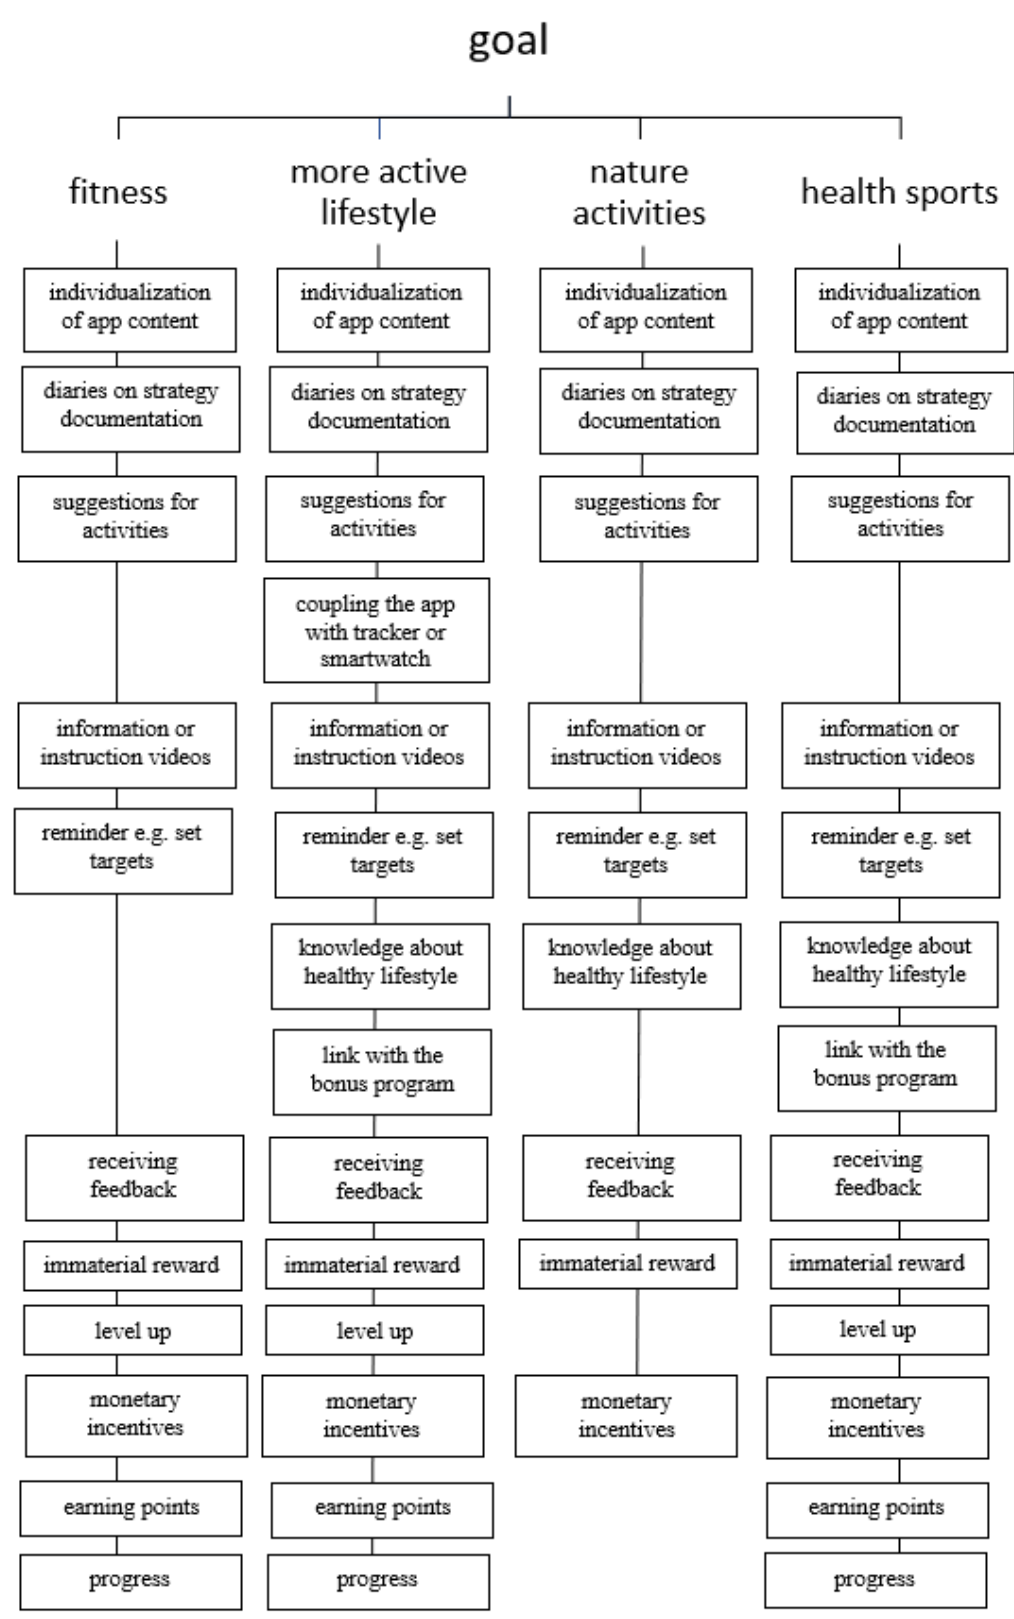
Figure 2. Interest of inactive persons in app features and gamification elements in an app to increase physical activity.